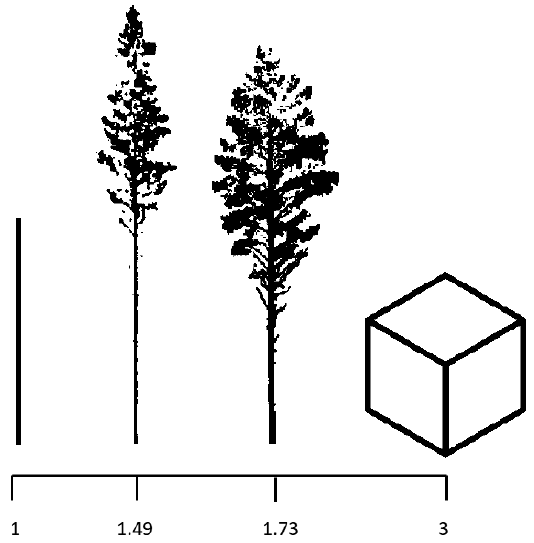
Figure 1. Illustration of objects with different box dimension (D b ) values: a pole (D b = 1), two structurally different Scots pine trees (D b = 1.49 and 1.73), and a cube (D b = 3). Modified after Figure 1 in Seidel [35].